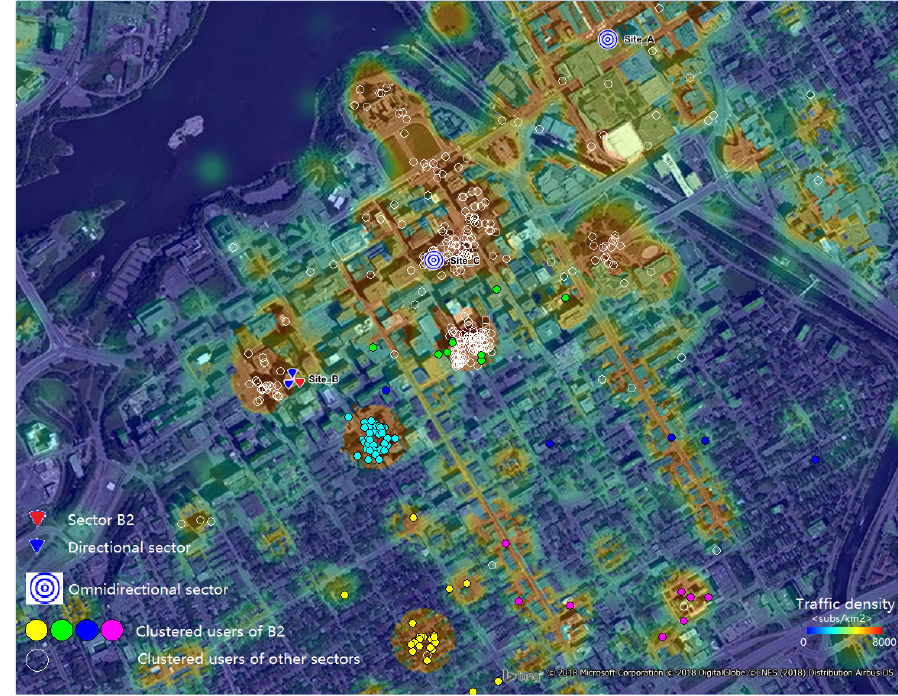
Figure 11. Busy hour user distribution and clustering for Sector B2 and ∆ θ = 30 ◦ .